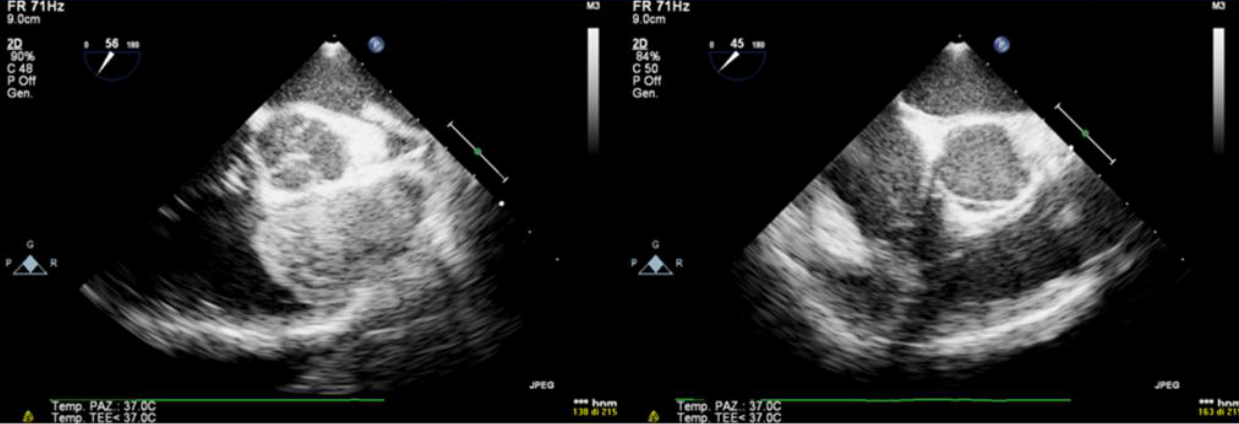
Figure 4. Computed tomography. Post-contrast CT confirms the presence of an ovoidal mass with smooth margins an- chored to the infundibular septum posteriorly, determining significant RVOT obliteration as shown in this frontal and later multiplanar reformatting view. The lesion has small tissue density with mild enhancement and patchy distribution. There was no CT evidence of mass infiltration, pericardial effusion or pulmonary embolism.